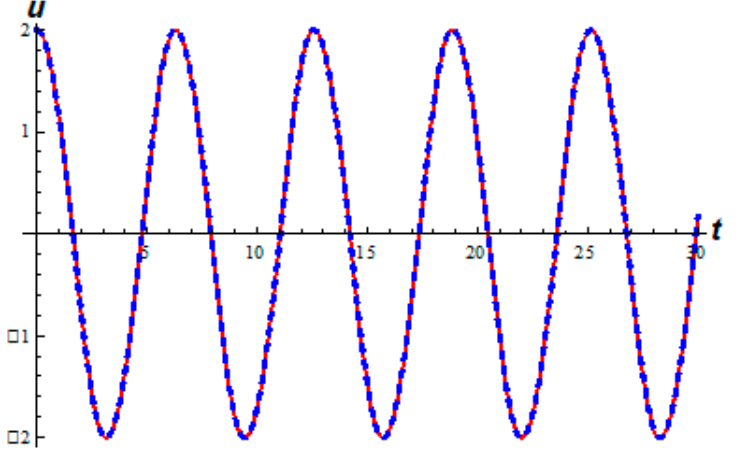
Figure 3. Plots of approximate displacement (red solid line) using the MDM and RK4 method (blue dashed line) for 0 ≤ t ≤ 30 and step-size h = 0.1.